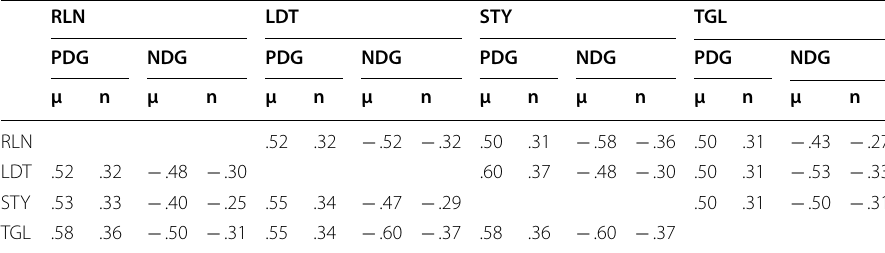
Table 4 Average values for the risks